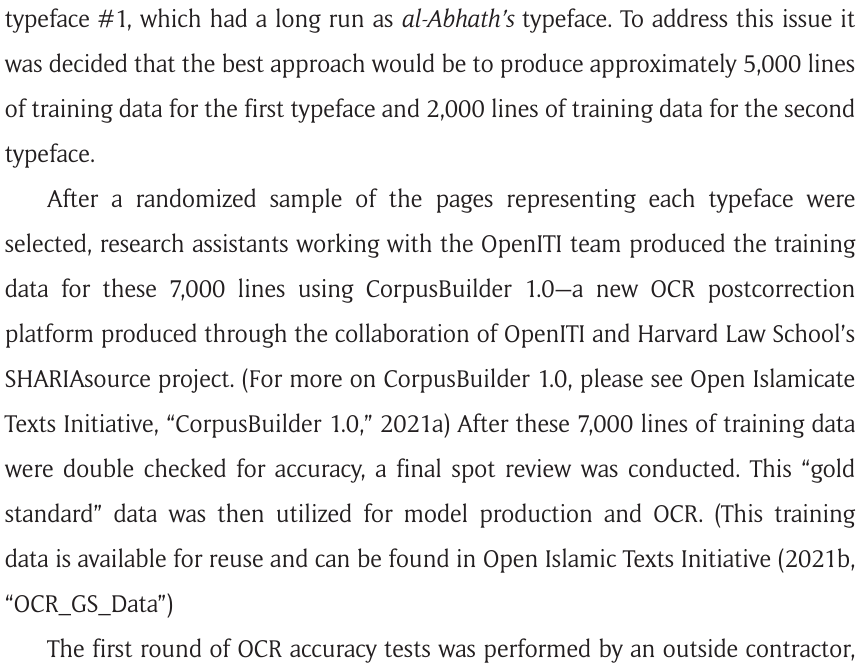
Figure 1: Typeface #1 Sample.